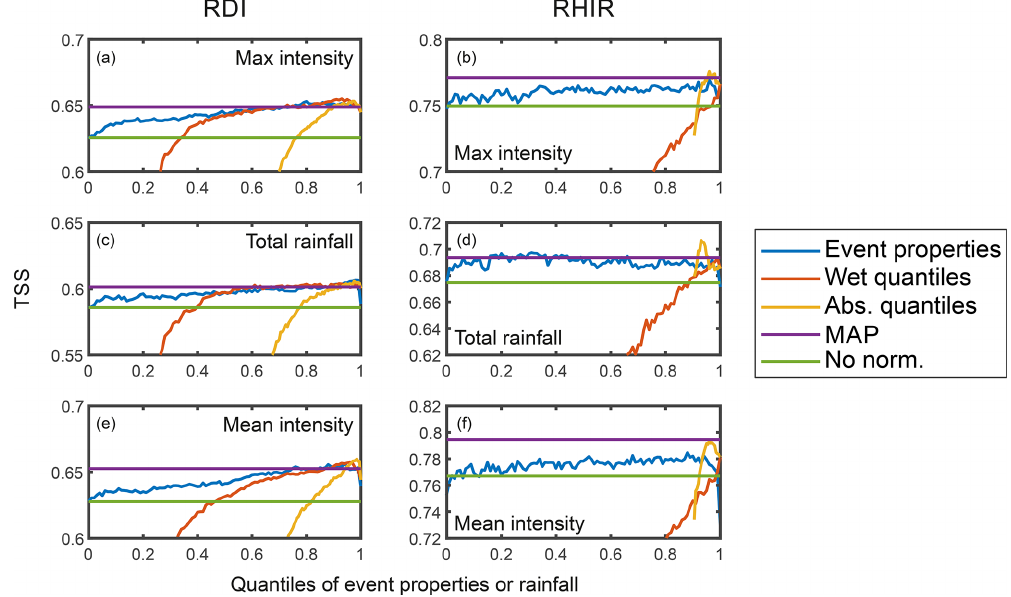
Figure 5. True skill statistic (TSS) values for the best threshold for the different normalisations, ( a, c, e ) for the daily (RDI) and ( b, d, f ) for hourly (RHIR) rainfall data, (a, b) for maximum rainfall, (c, d) for total rain, and (e, f) for mean intensity. For the normalisation by event properties (event properties) and quantiles of rainfall (wet and absolute), the TSS is computed for each 0.01 quantile value ( x axis). For the normalisation by mean annual precipitation (MAP) and the TSS value of the variable without normalisation (no normalisation), the constant value of the TSS is indicated as a straight line across all x values.